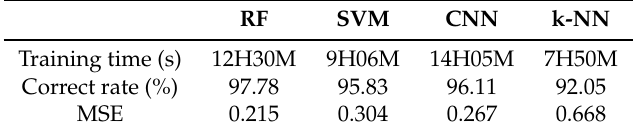
Table 2. Results of classification algorithms: RF, SVM, CNN, k-NN of FVC database.